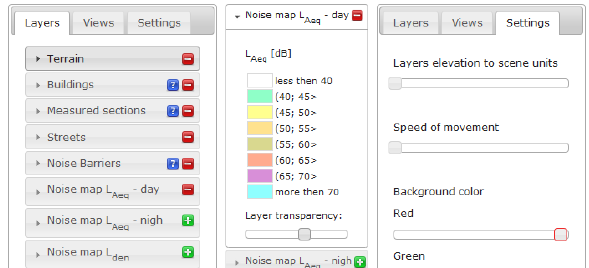
Figure 7. Detail of the right panel (from the left) – layer switcher, legend, and scene setting